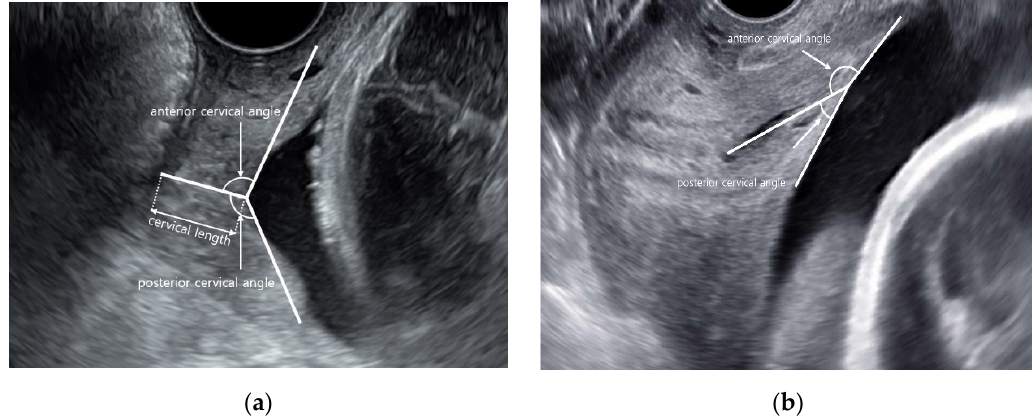
Figure 1. Transvaginal ultrasound cervical measurements. Cervical length, angle between anterior and posterior uterine wall, and internal cervical os in straight cervix ( a ) and curved cervix ( b ).